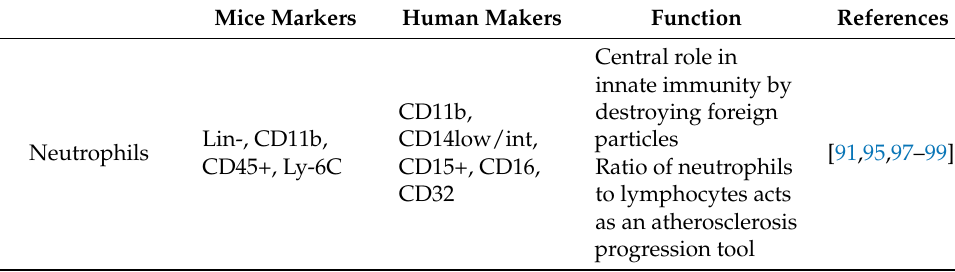
Table 4. Neutrophils and their role in